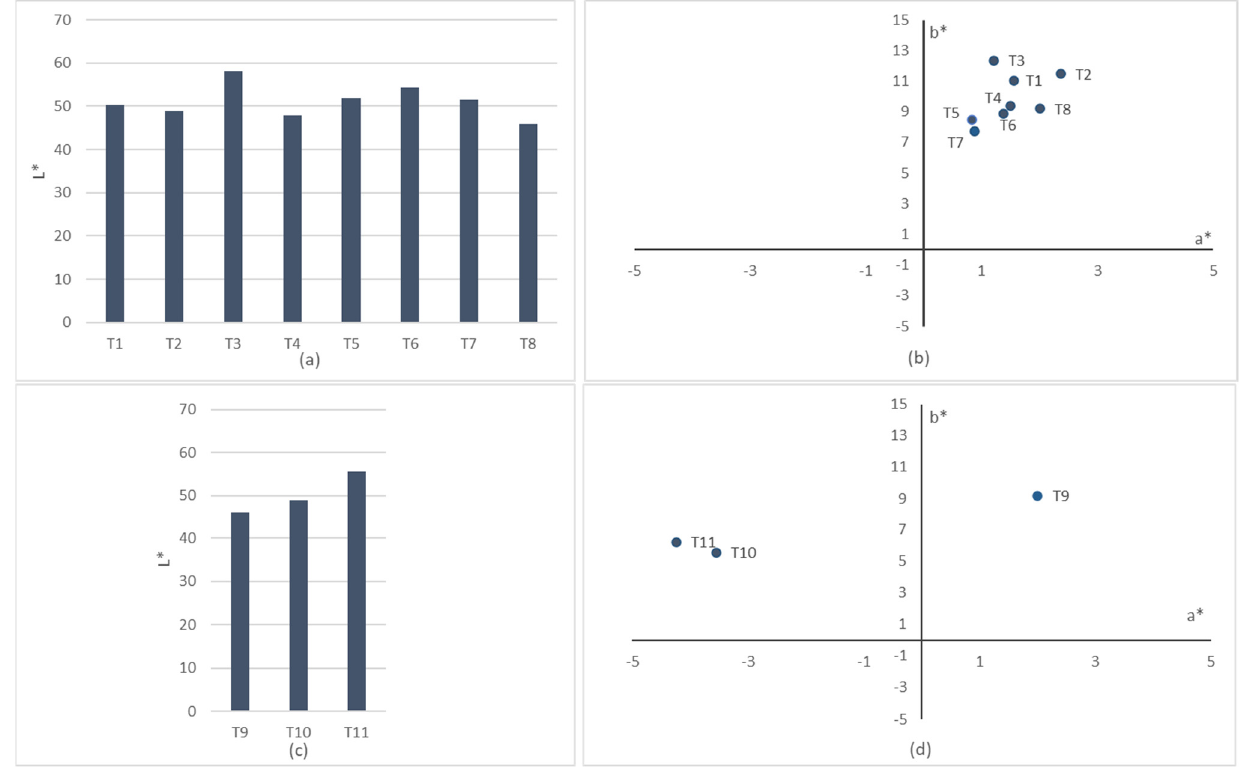
Figure 4. Two-dimensional CIELAB (+L*, +a *, +b*) coordinates representation. ( a ) CIELAB lightness (+L*) of textile structure variations T1–T8; ( b ) CIELAB a* and b* coordinates of textile structure variations T1–T8; ( c ) CIELAB lightness (+L*) of textile material variations T9–T11; ( d ) CIELAB a* and b* coordinates of textile material variations T9–T11.